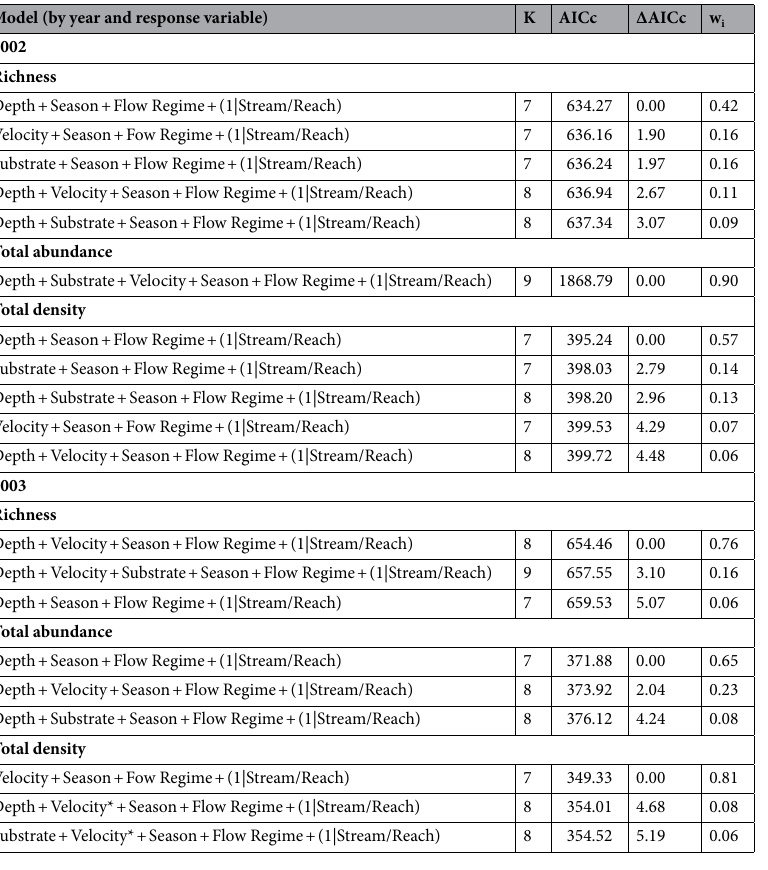
Table 3. Mixed models ranked by AIC c for three response variables in 2002 and 2003. Models with Akaike weights > 0.05 are